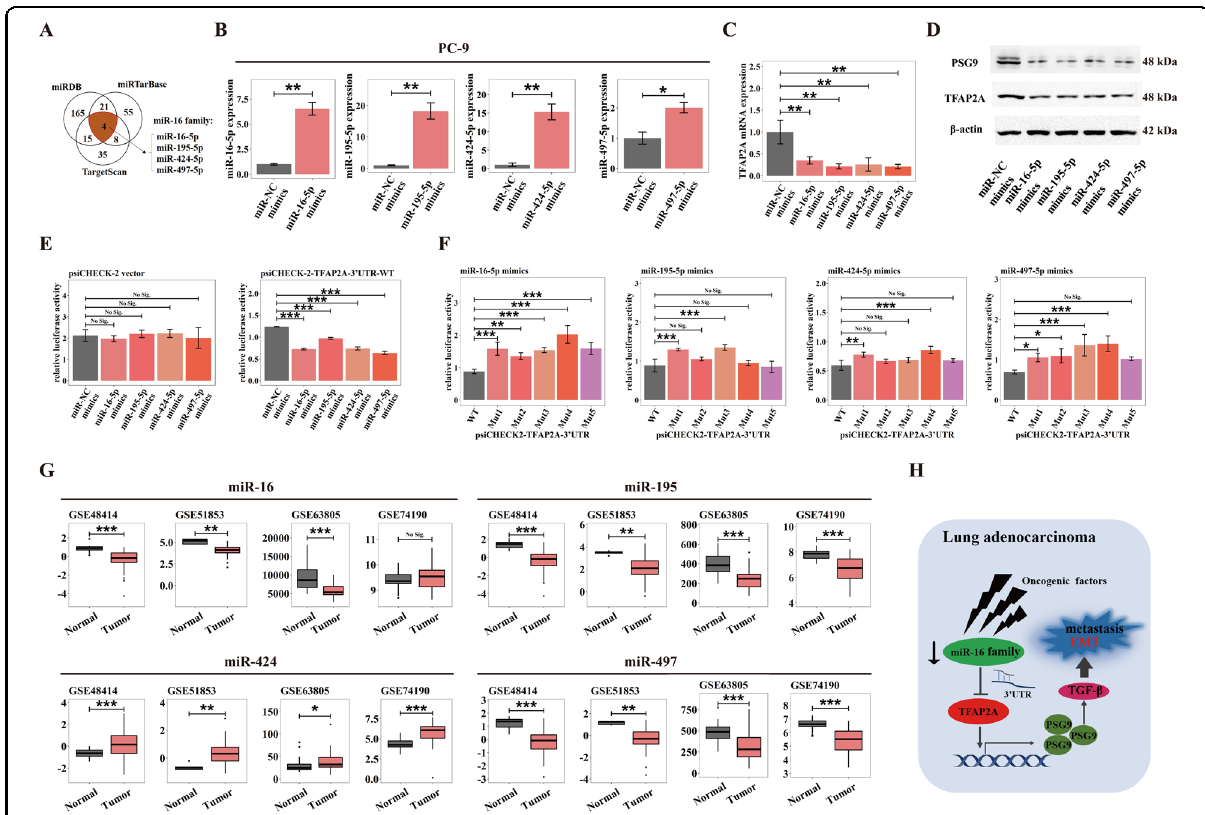
Fig. 6 Post-transcriptional silencing of TFAP2A by miR-16 family is attenuated in LUAD. A Venn diagram exhibiting miRNAs possibly regulating TFAP2A via bioinformatic prediction from three miRNA database (miRDB, miRTarBase and TargetScan). B Overexpression ef fi cacy for miR-16/195/424/ 497-5p mimics in PC-9. C In fl uence on TFAP2A transcript levels of miR-16/195/424/497-5p mimics transfection in PC-9. D In fl uence on TFAP2A and PSG9 protein levels of miR-16/195/424/497-5p mimics transfection in PC-9. E Dual luciferase assays of HEK293T co-transfected with miR-16/195/424/ 497-5p mimics and psiCHECK-2-TFAP2A-3 ′ UTR-WT luciferase reporter (right) or control psiCHECK-2 vector (left). F Dual luciferase assays of HEK293T co-transfected with miR-16/195/424/497-5p, psiCHECK-2-TFAP2A-3 ′ UTR-WT (WT) and psiCHECK-2-TFAP2A-3 ′ UTR-Mut1/2/3/4/5 (Mut) luciferase reporters. G miR-16/195/424/497 levels between tumors and normal tissues in four LUAD datasets (GSE48414, GSE51853, GSE63805 and GSE74190). H In LUAD, multiple oncogenic factors induce miR-16 family suppression, thus hindering TFAP2A from post-transcriptional silencing by miR-16 family, therefore increased TFAP2A transactivates PSG9 to facilitate TGF- β signaling-triggered EMT and subsequent metastasis. * p < 0.05; ** p < 0.01; *** p < 0.001. N ≥ 3, Data are presented as mean ± SD or through